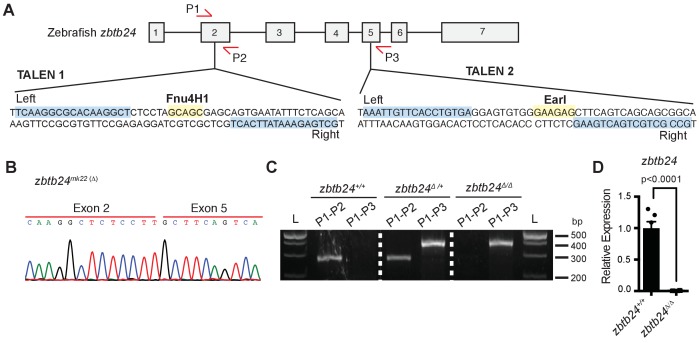
TALEN design for introducing mutations at the endogenous zbtb24 zebrafish gene.(A) Schematic of TALEN sequences showing target sites for introducing mutations in zbtb24. P1, P2 and P3 indicate locations for genotyping primers. Sequence in blue indicate target site. Sequence in yellow indicates site of restriction enzyme digestion. (B) Sequence trace confirming generation of large deletion, zbtb24mk22(∆). (C) Representative genotyping of zbtb24mk22(∆) allele. L: Ladder. P1, P2, P3 represent primers from panel A used for amplifying product in specified lane. (D) qRT-PCR analysis of zbtb24 mRNA in zbtb24+/+ and zbtb24Δ/Δ zebrafish at 2 wpf (n = 6 for each group).